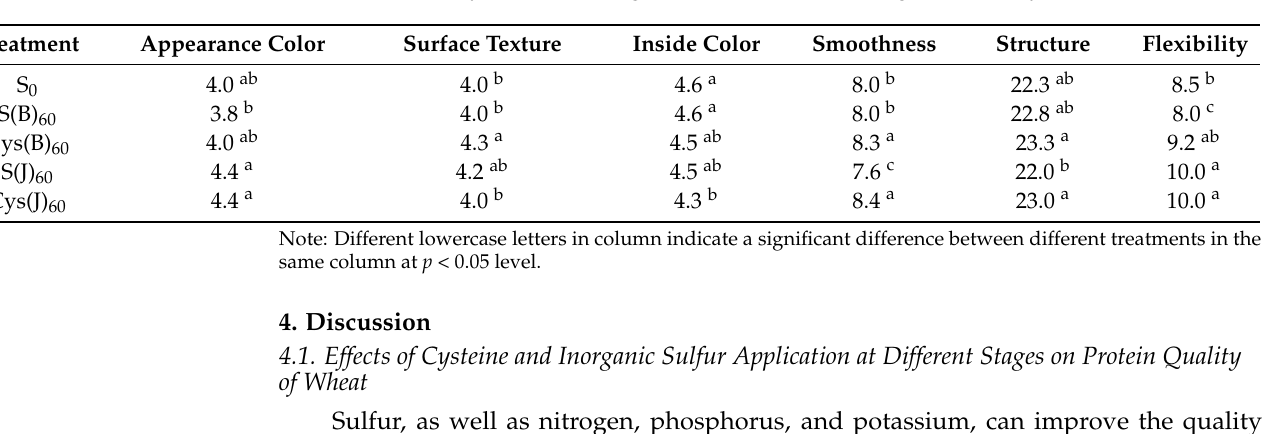
Table 5. Effects of cysteine and inorganic sulfur at different stages on sensory evaluation of